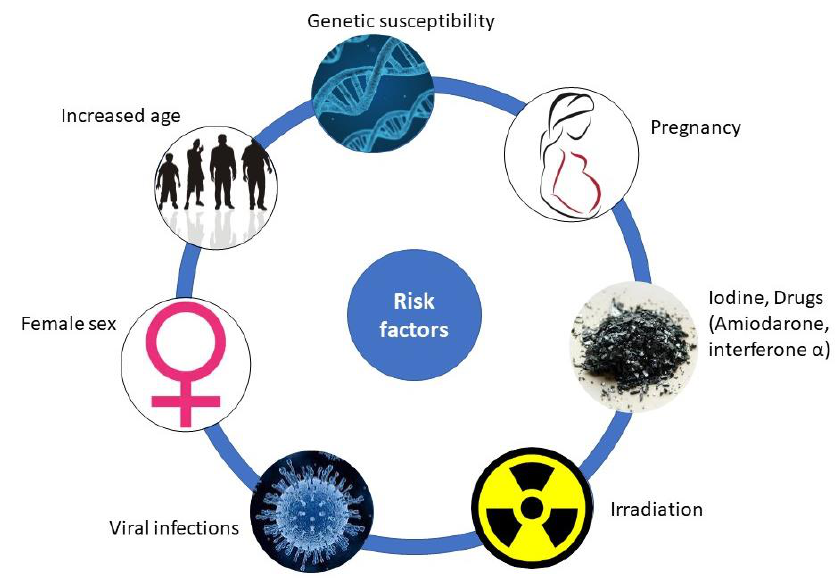
Figure 2.2. Risk factors for Hashimoto’s thyroiditis (2), (5), (18), (19), (20), (21), and